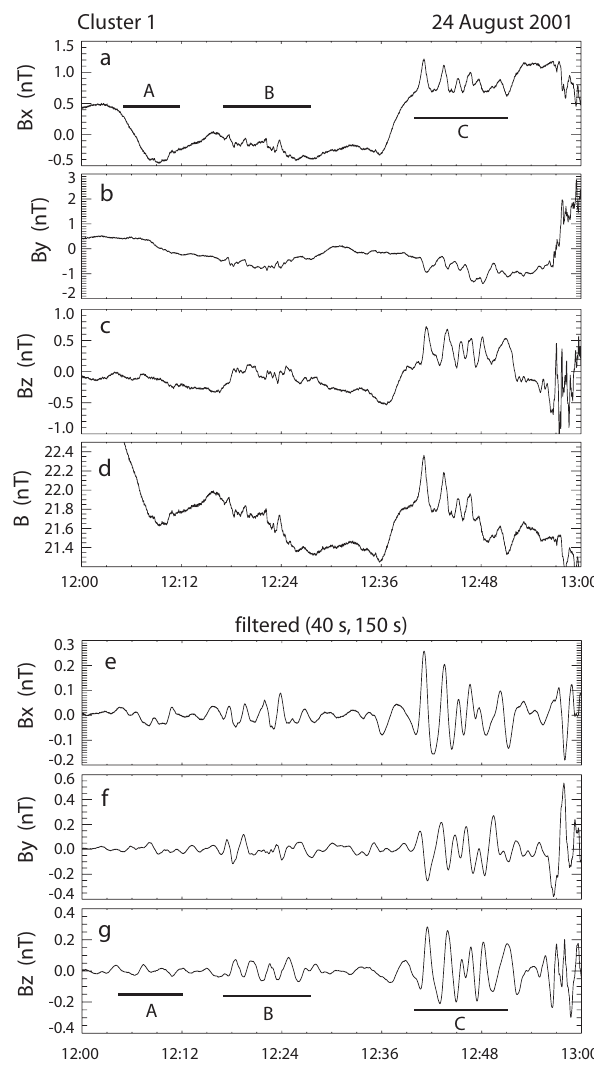
Fig. 2. Magnetic field data from Cluster 1 encompassing three events (A, B, and C) on 24 August 2001. (a–d) Data were aver- aged (4s); (e–f) Data were averaged (40s) and detrended (150s).